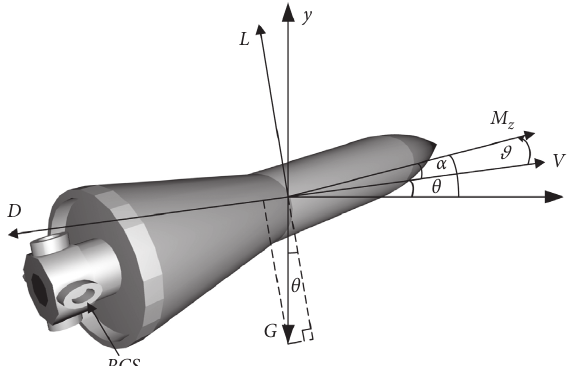
Figure 1: Motion coordinate systems of the maneuverable reentry vehicle. This is the basic shape of the maneuverable reentry, with the tail of the main engine and the RCS